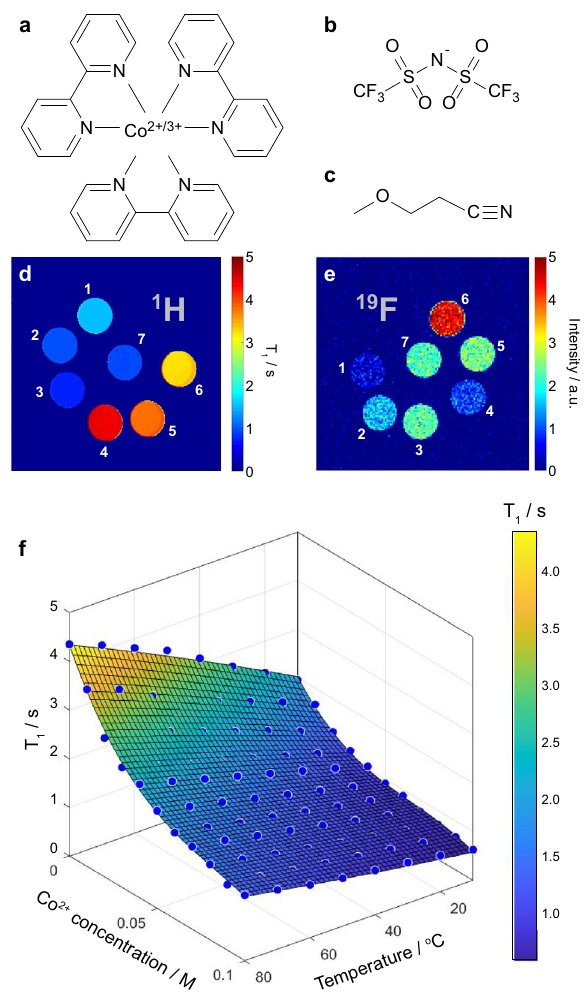
Fig. 2 The electrolyte system studied and T 1 relaxation data used for image calibrations. Molecular structures of a the tris(bipyridyl)cobalt cation Co(bpy) 3 , b the bis(tri fl uoromethanesulfonyl)-imide anion (TFSI) and c the 3-methoxypropionitrile (MPN) solvent. d , e Axial slice 1 H T 1 and 19 F spin density contrast images obtained from electrolyte samples in 5 mm diameter NMR tubes at 20 °C (MPN with (1) 0.05 M Co 2 + (bpy) 3 (TFSI) 2 , (2) 0.10 M Co 2 + (bpy) 3 (TFSI) 2 , (3) 0.15 M Co 2 + (bpy) 3 (TFSI) 2 , (4) 0.05 M